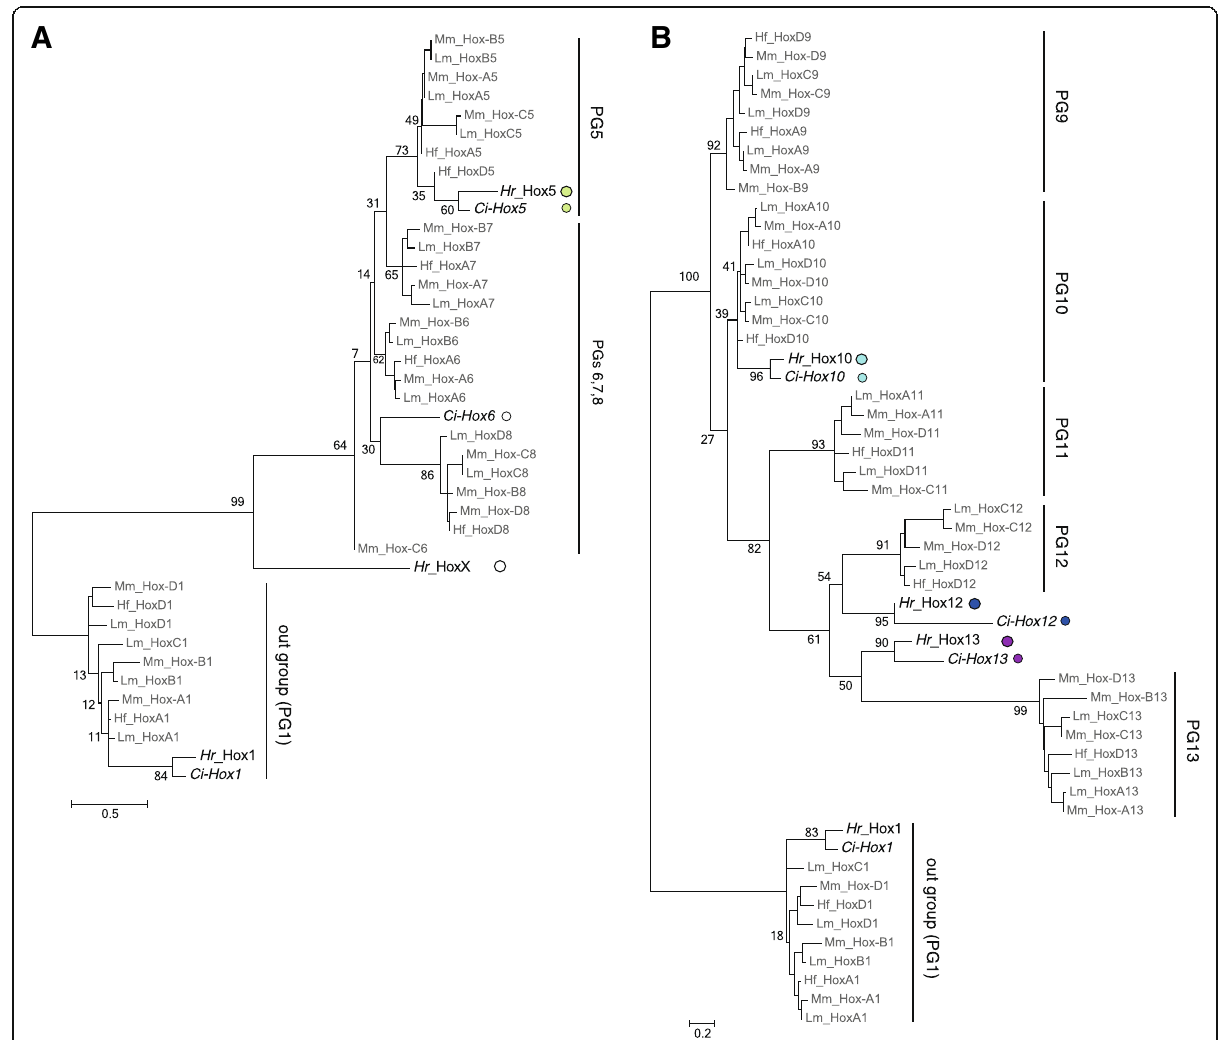
Fig. 2 Phylogenetic analysis of Hox gene candidates of Halocynthia roretzi , using PGs 5 – 8 a and PGs 9 – 13 b genes, and PG1 genes were used as an out group. The ML tree was constructed using homeodomain sequences and the adjacent 20 N-terminal side and seven C-terminal side amino acid residues (see Additional file 1: Figure S1) with MEGA5 software and 1000 replicates. The percentage of replicated trees in which the clustering of genes was supported is indicated at the nodes. Within a clade consisting of only vertebrate Hox genes, the percentage was not indicated at the node. Colored circles to indicate ascidian genes and taxonomic abbreviations are the same as in Fig. 1. The bars at the bottom indicate amino acid substitutions per position in the